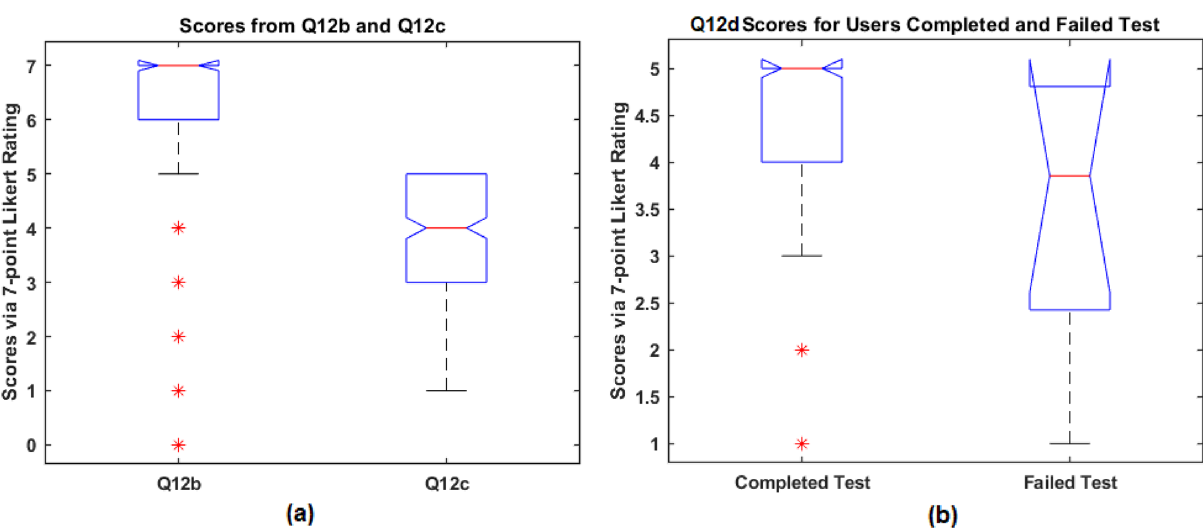
Figure 11. The boxplot for: ( a ) scores from Q12b and Q12c to assess the user-perceived ease of using the kit after and before the test; ( b ) scores for Q12d (to assess the confidence in using the kit) from the users who completed and failed the